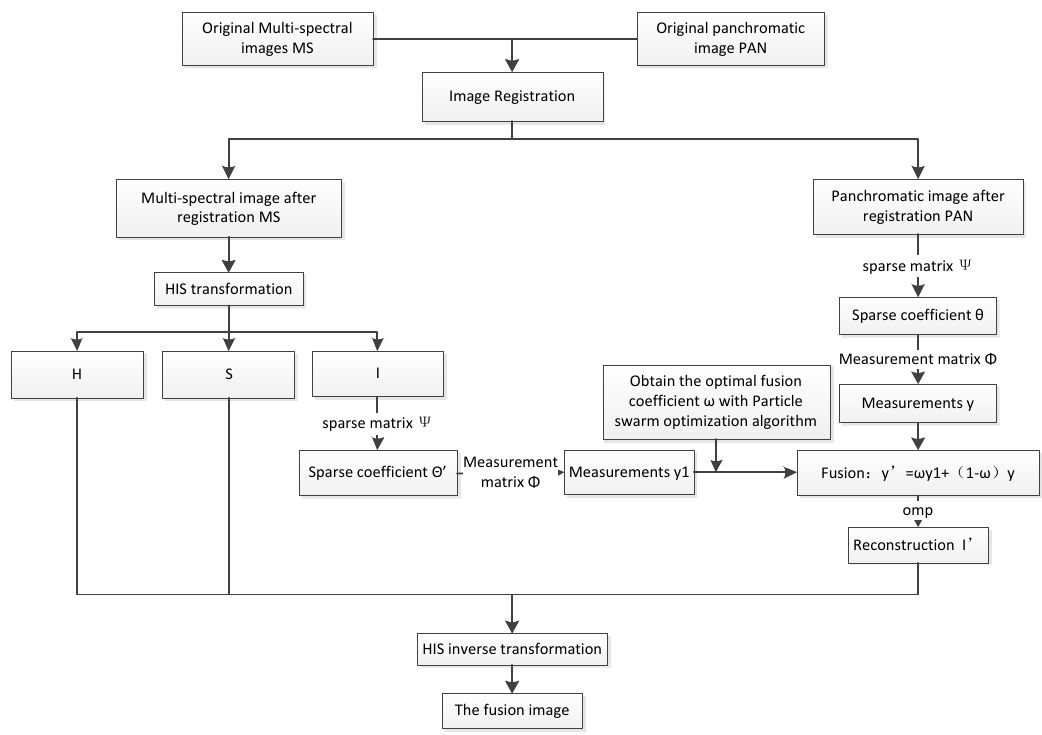
Figure 3 The flow chart of HIS - CS image fusion algorithm based on particle swarm optimization algorithm The process of HIS-CS image fusion based on Particle swarm optimization (PSO) is as